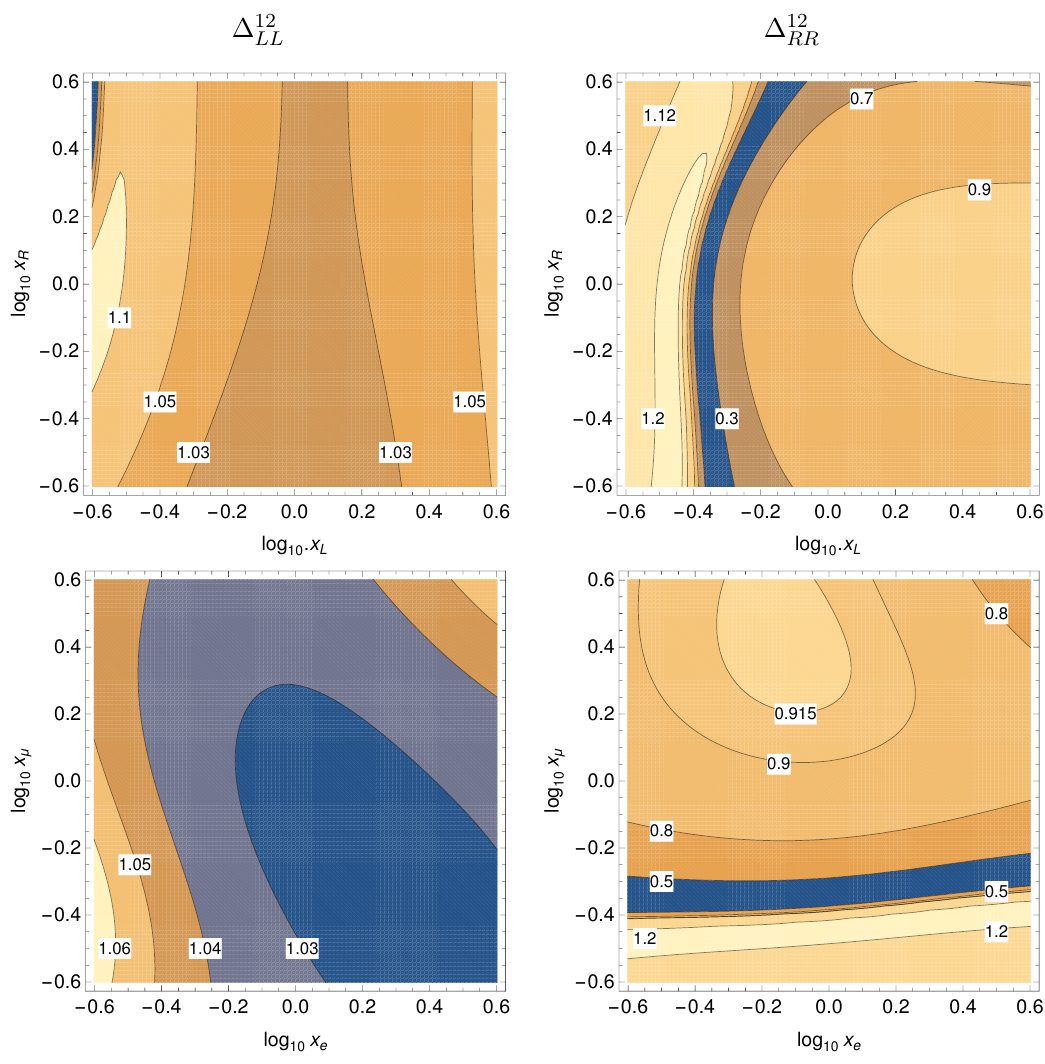
Figure 11 . The ratio R ‘‘ 0 as a function of the mass splitting between left and right slepton masses (upper row) and between the selectron and smuon masses (lower row) for M = 800 GeV as a function of the normalised slepton masses x L ( R ) = m L ( R ) =M and x ~ e (~ (cid:22) ) = m ~ e (~ (cid:22) ) =M